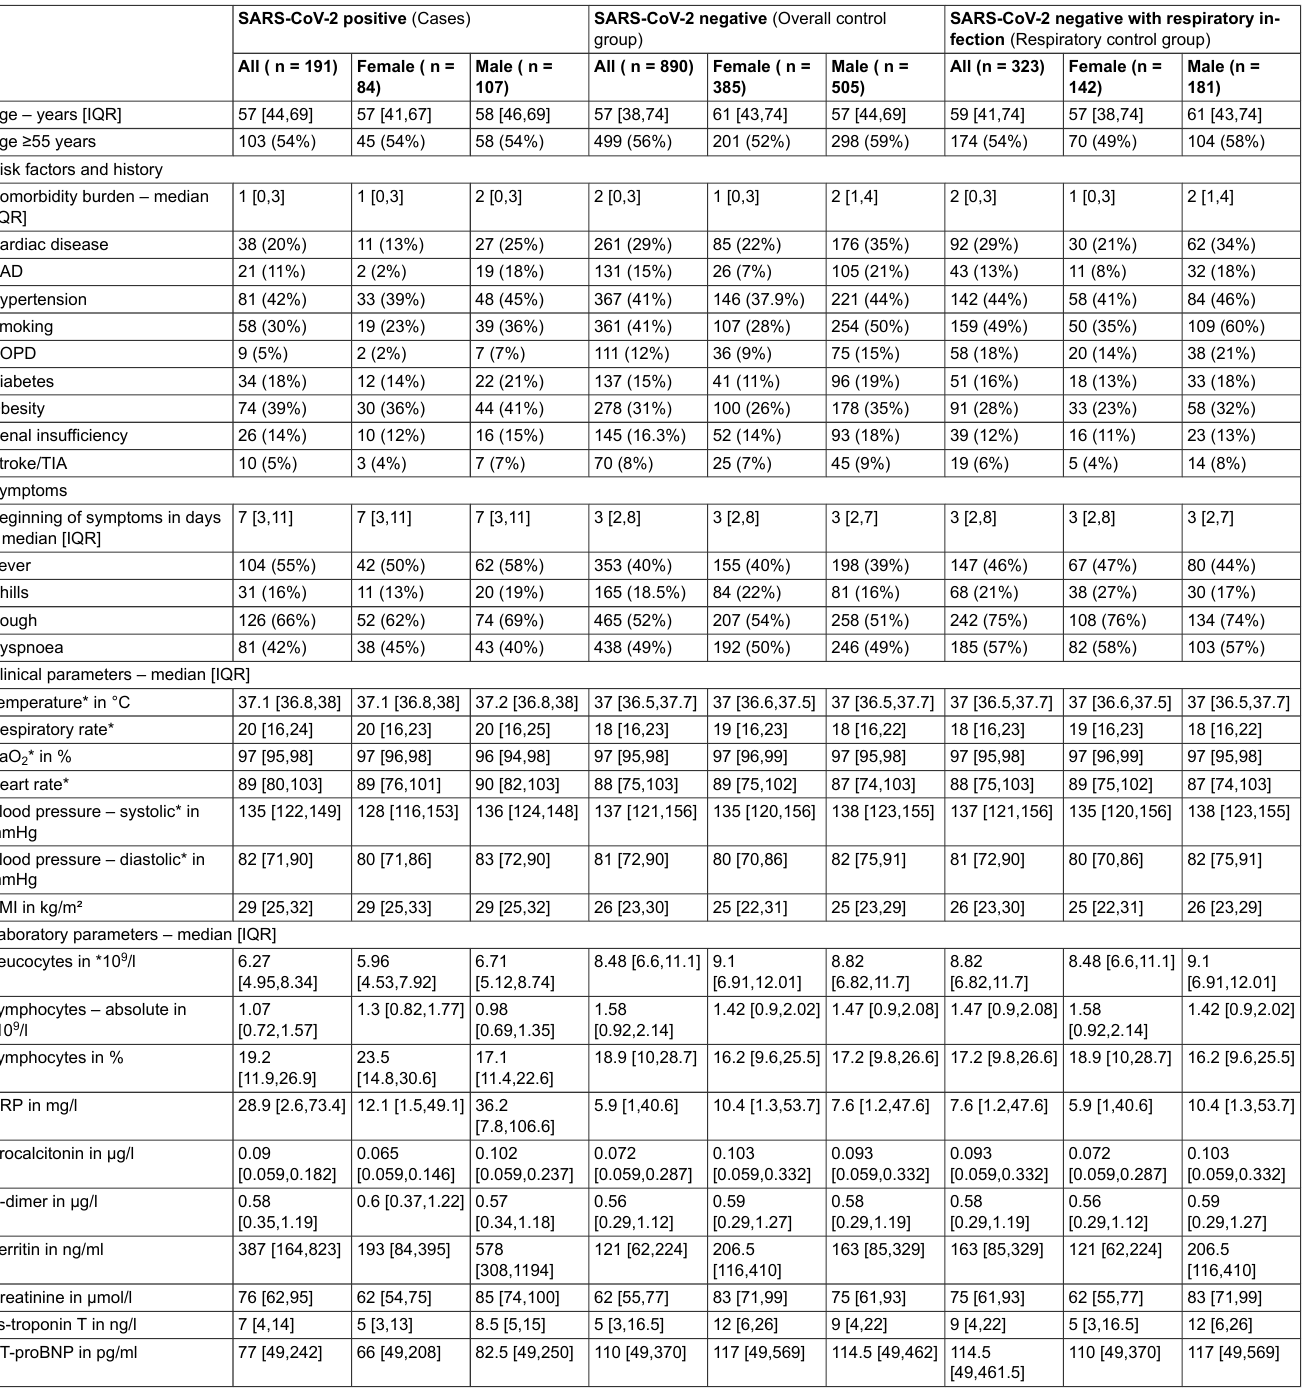
Table 1: Clinical characteristics.